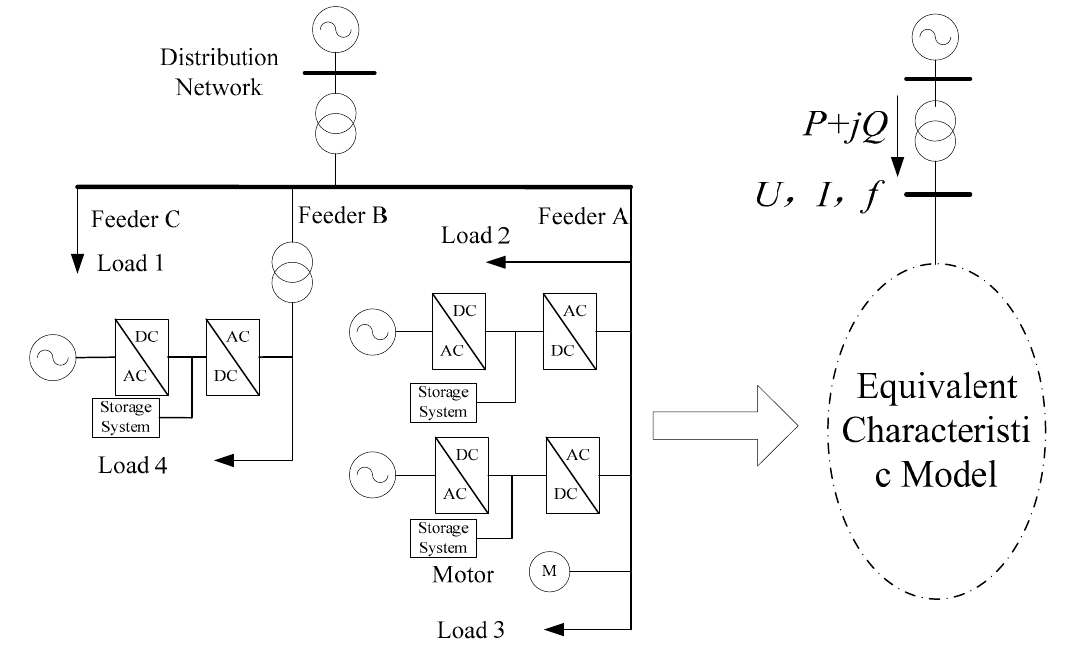
Figure 4. Concept of microgrid equivalent modeling.